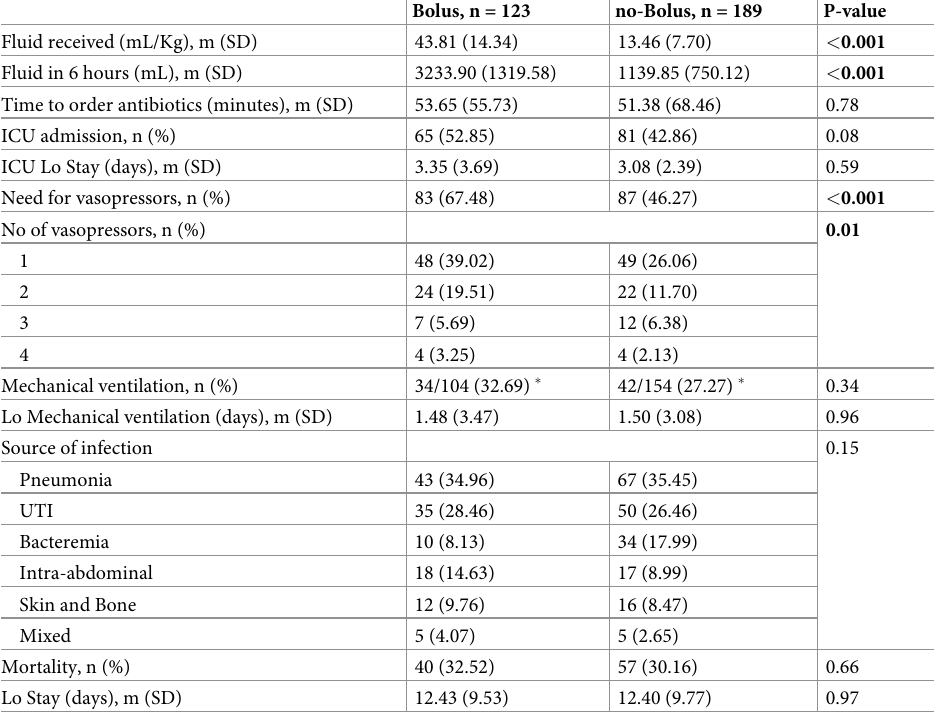
Table 5. Comparison of secondary outcomes in the congestive heart failure